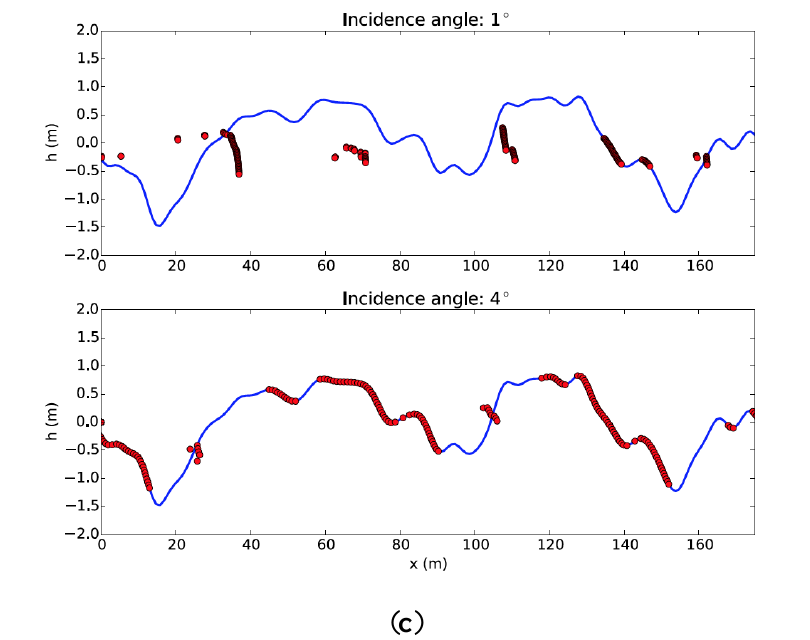
Figure 3. ( a ) Simulated Pierson-Moskowitz ocean wave field (U10=10m/s) propagating in the range direction (blue) and sampled by a set of parallel planes (dashed gray) separated by 20 m in range. The top figure represents the sampling when the local incidence angle is 1°, while the bottom figure shows the same wave field when the incidence angle is 4°. The intersection of a sample plane with the mean level is shown as a black square, while the sampled heights are shown as red circles. The radar is on the left and the radar pulses propagate from left to right. ( b ) True (blue) and measured (red) heights for wave field presented in ( a ) for a system with finite resolution bandwidth (surface impulse response), plotted as a function of the intersection of the range coordinate with the mean surface. ( c ) Estimated height as a function of estimated cross track, assuming a noiseless